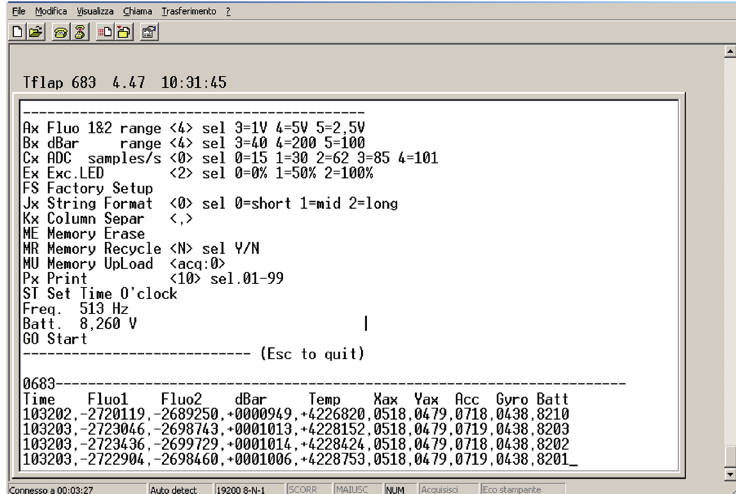
Figure 2. Terminal screen showing the different instruments and sensor configurations and